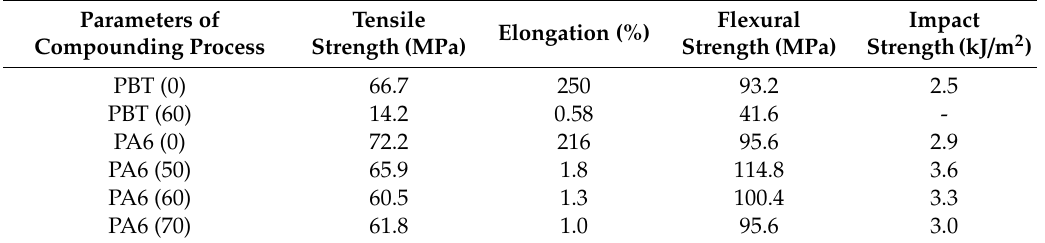
Table 2. Mechanical properties of PA6 / PBT / Al 2 O 3 composites with di ff erent weight ratios. Parameters of Compounding Process